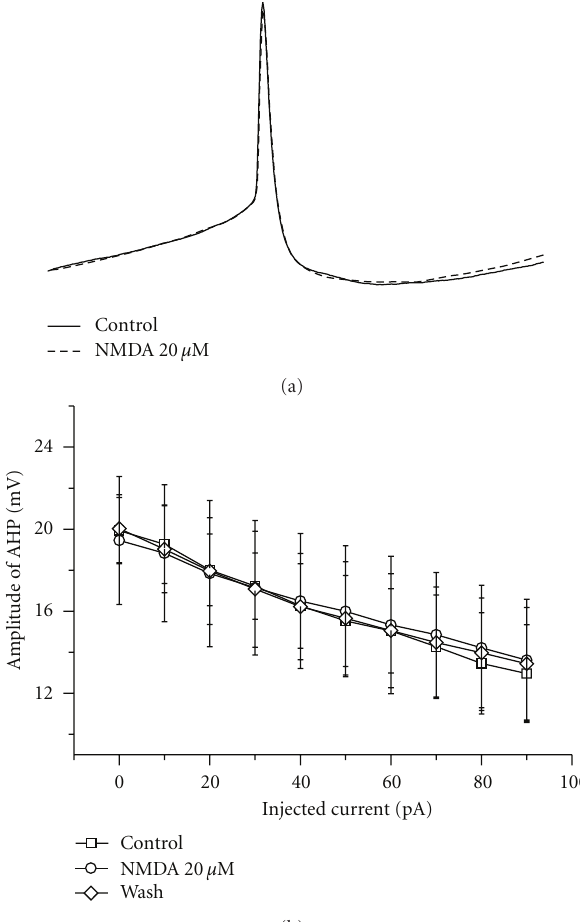
Figure 3: The e ff ect of NMDA on the spike AHP in RA projection neurons. (a) Action potentials evoked by 90pA current injection are overlaid to compare the change of AHP by NMDA application. There is no obvious change in spike shape. The spike in control is shown as a solid line, and that in NMDA is shown as a dash line. (b) Plot of amplitude of AHPs versus injected current. NMDA did not cause a significant change in average amplitude of AHPs ( n = 5). Paired t -test was used to evaluate the di ff erences between the groups.